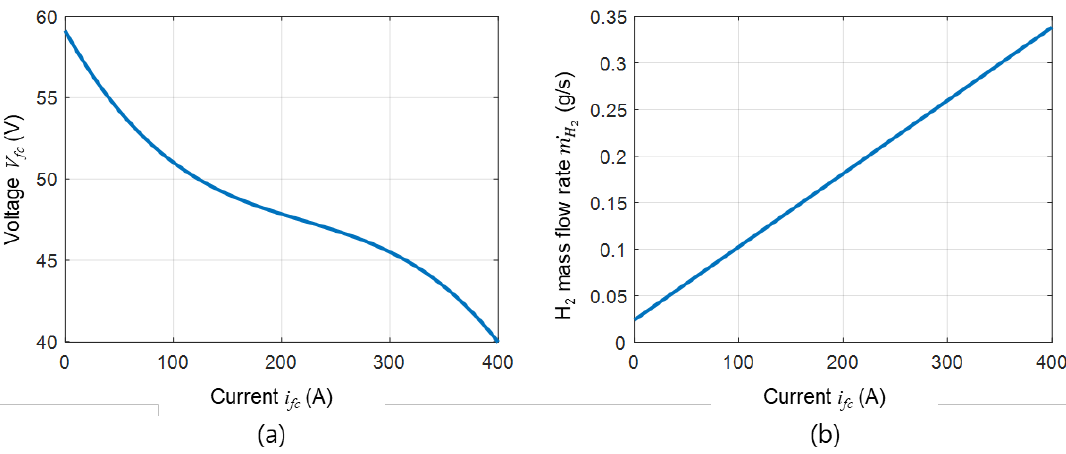
Figure 2. Fuel cell system modeling: ( a ) Fuel cell model; ( b ) Hydrogen consumption model.